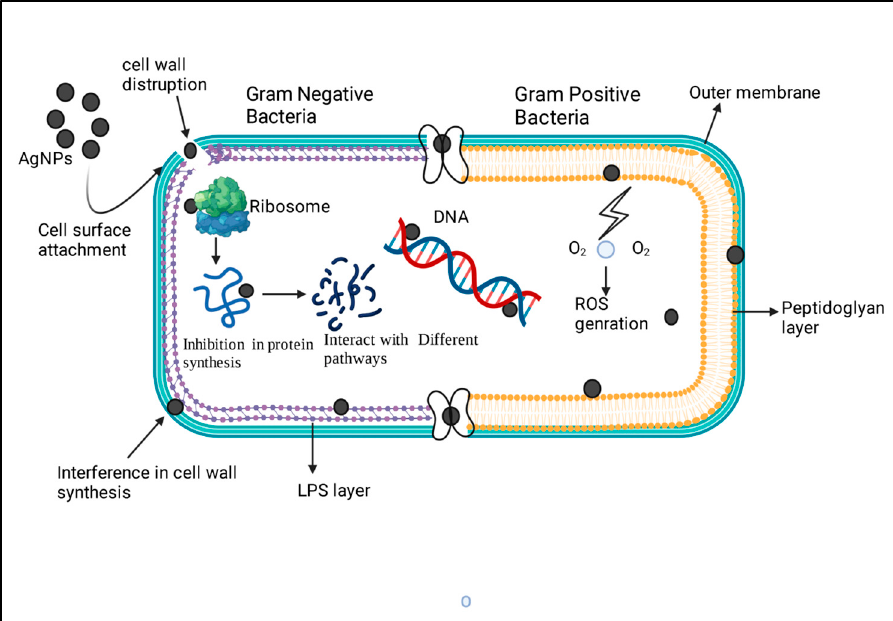
Figure 3. The comparative mechanistic approach of AgNPs on Gram-positive and Gram-negative bacteria surfaces has been explained. The left indicates the Gram-negative bacteria, while the right is a Gram-positive bacterial representation. The NPs will attach to the surface of the bacterial cell wall and depending on the cell wall composition, the NPs enter inside the bacterial cell. Furthermore, this leads to altering the other mechanistic approaches of the organism, likely protein synthesis, ROS pathway, and DNA replication.